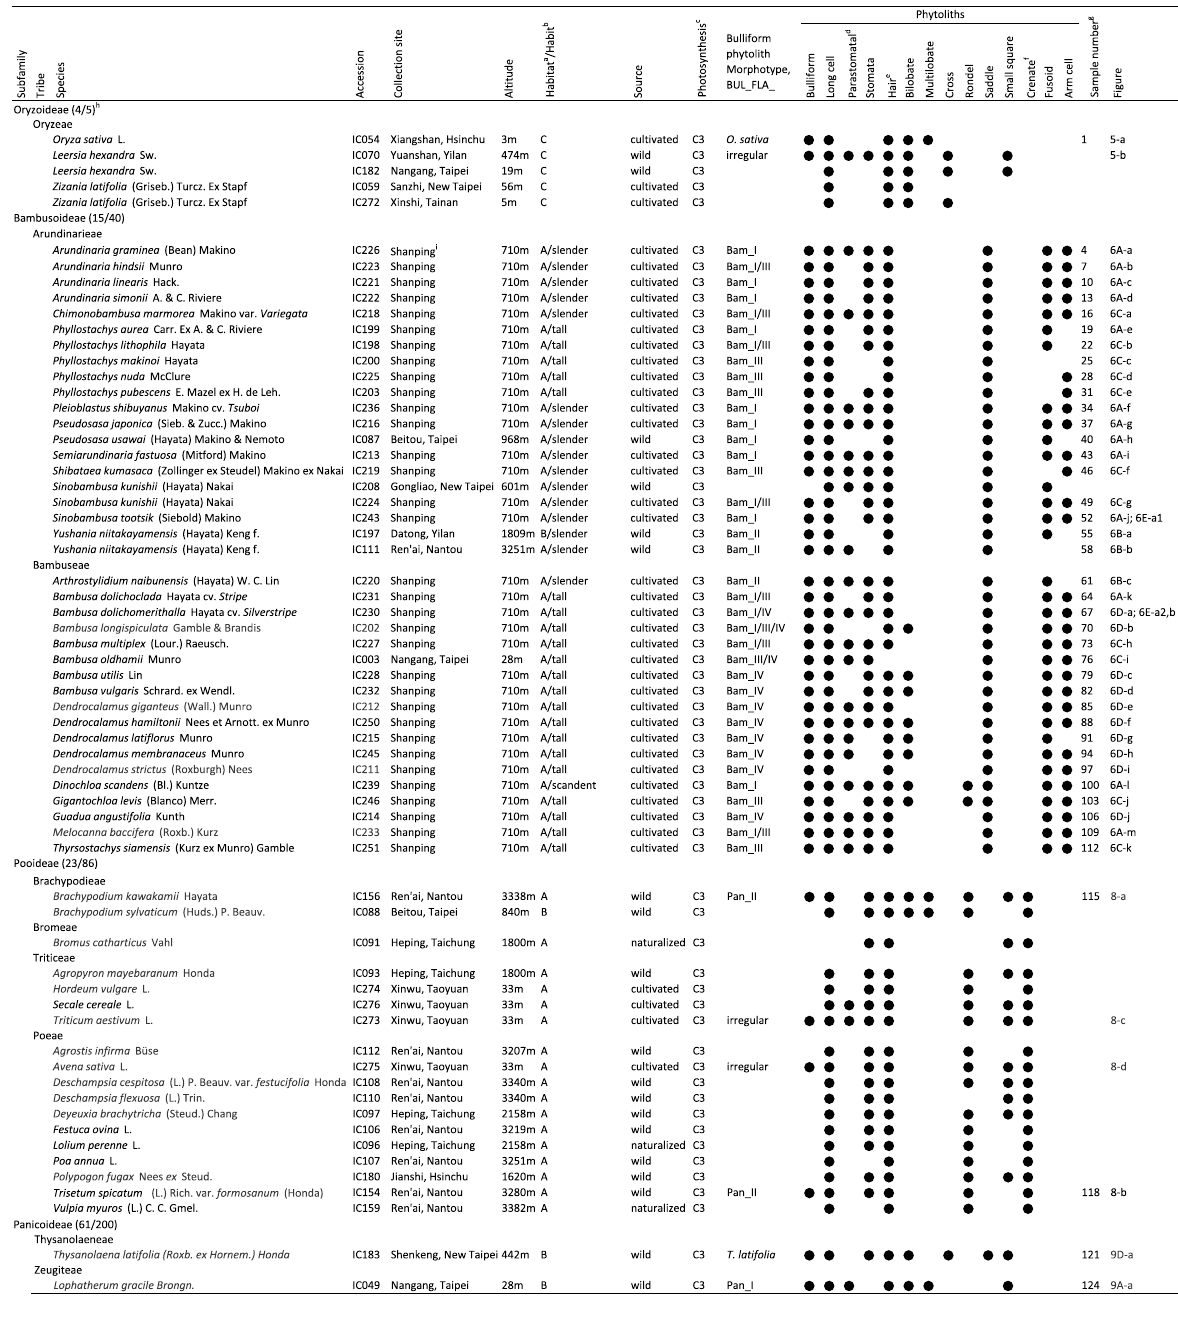
Table 1 Poaceae species sampled for leaf phytoliths in this